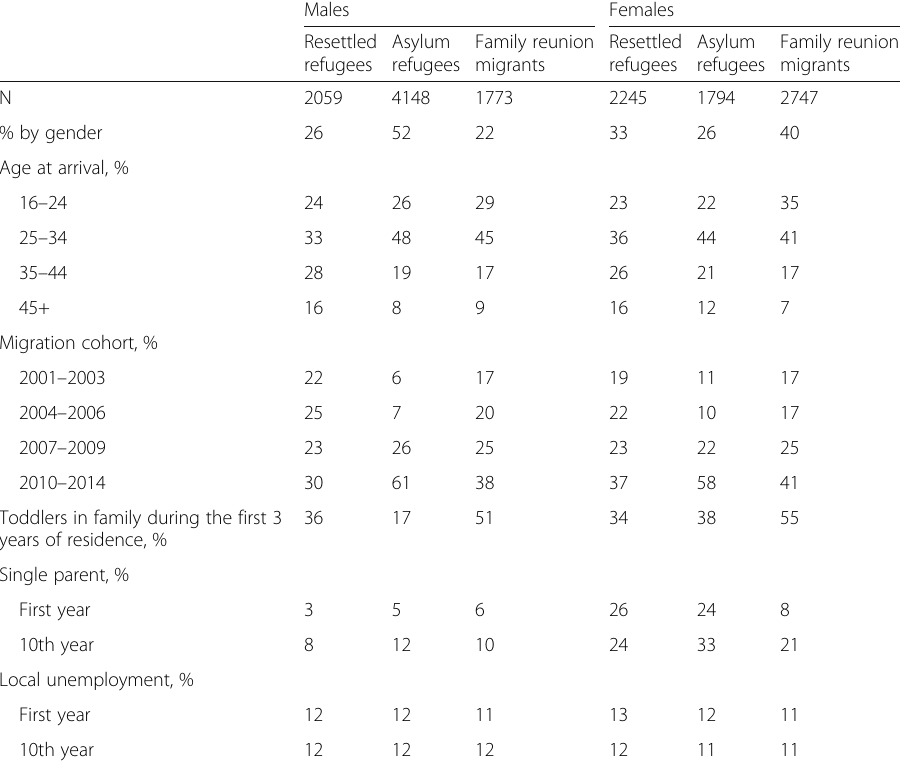
Table 1 Descriptive statistics of the study